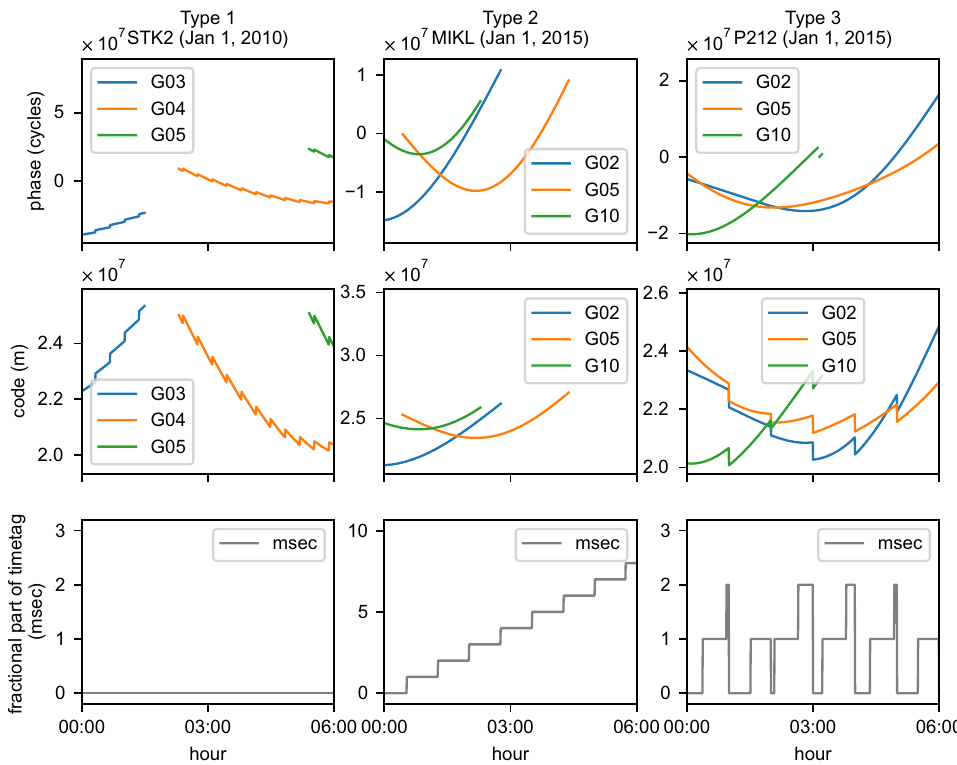
Fig. 2 Examples of observation data using different types of clock jumps: a Type 1, b Type 2, and c Type 3 clock jumps. The top, middle and bottom panels show phase and code pseudoranges, and millisecond part of time tag, respectively. The observation data of IGS sites STK2 (January 1, 2010) and MIKL (January 1, 2015), and GEONET site P212 (January 1, 2015) are